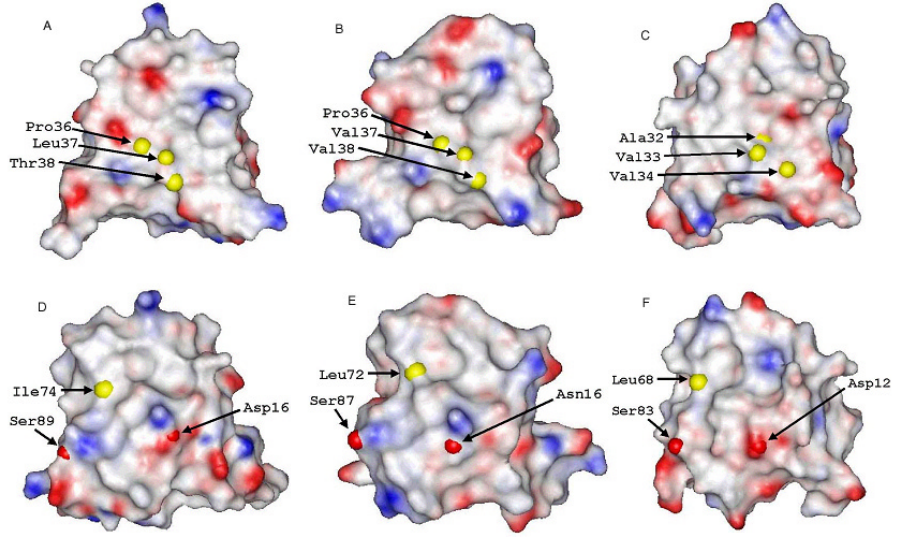
FIGURE 3. The largest conserved semi-planar surfaces of the Tcl1 protein members is shown with the surface charge distribution for: (A) human Tcl1, (B) mouse Tcl1, and (C) human Mtcp1. Blue indicates positive charge distribution and red indicates negative. The human Tcl1 residues Pro36, Leu37, and Thr38 found to be important for dimer formation are shown and equivalent residues are indicated in the other proteins. The Tcl1 surfaces proposed to interact with Akt/PKB are shown for: (D) human Tcl1, (E) mouse Tcl1, and (F) human Mtcp1. This surface is located opposite to the dimer surface shown in views A-C. The conserved serine is indicated. Human Tcl1 Asp16 and Ile74 found to be important for interactions with Akt are shown in D, and the equivalent residues in mouse Tcl1 and Mtcp1 are indicated in E and F. The surface pictures were generated with the program WebLab ViewerLite[16] using a probe radius of 2.5